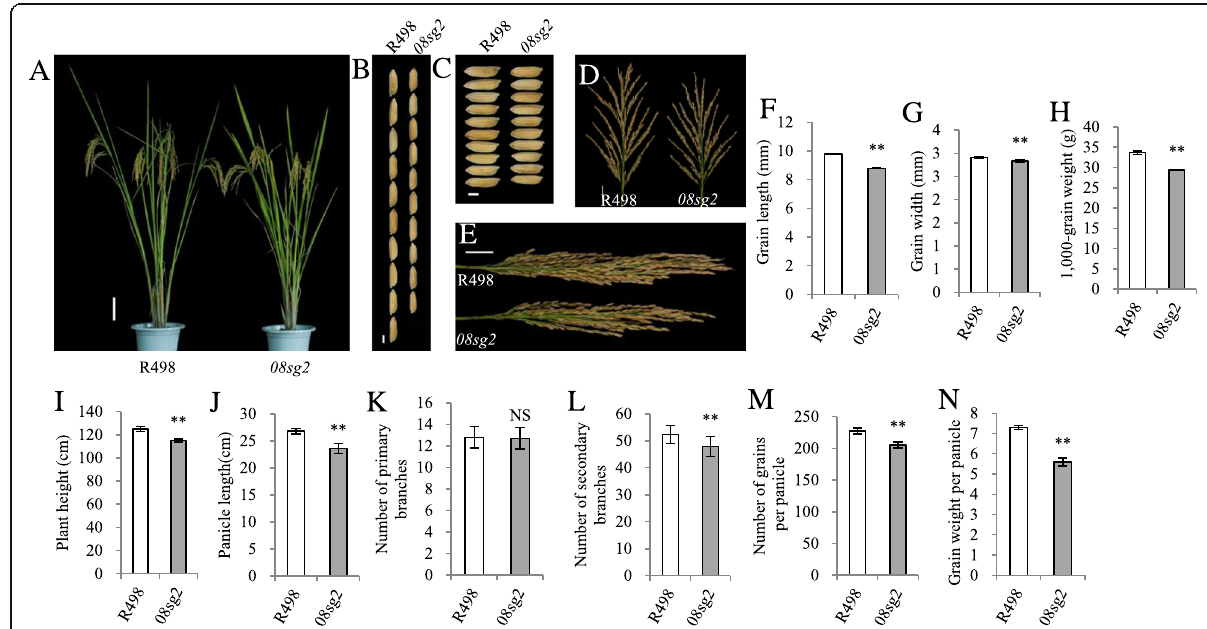
Fig. 1 Comparisons of phenotype between R498 and 08sg2 . a The phenotype of R498 and 08sg2 at reproductive stage. Scale bar, 10 cm. b , c Comparisons of the grain length and grain width between R498 and 08sg2 . Scale bar, 3 mm. d , e The panicle morphology of R498 and 08sg2 . Scale bar, 3 cm. f Grain length. g Grain width. h 1,000-grain weight. i Plant height. j Panicle length. k Number of primary branches. l Number of secondary branches. m Number of grains per panicle. n Grain weight per panicle. All phenotypic data in F – N were measured from plants grown in paddies under normal cultivation conditions with three-time repeats. Data are given as means± SD. Student ’ s t-test was used to generate the P values; ** and NS indicate P < 0.01 and no significant differences,